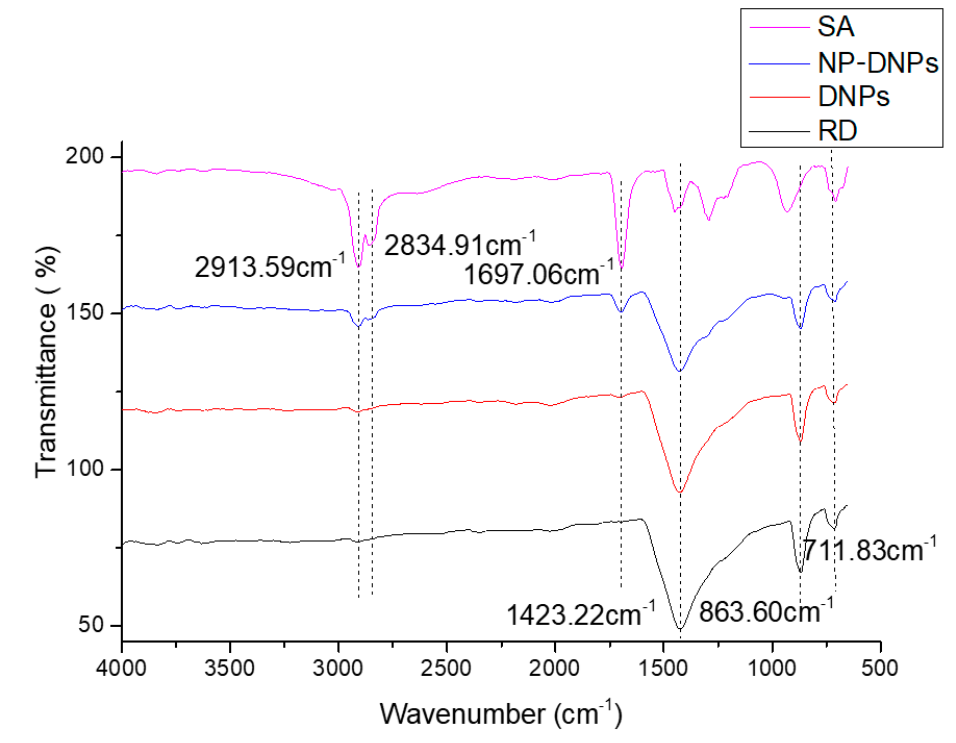
Figure 9. FTIR spectra of raw dolomite (RD), dolomite nanoparticles (DNPs), non-polar dolomite nanoparticles (NP-DNPs), and stearic acid (SA).